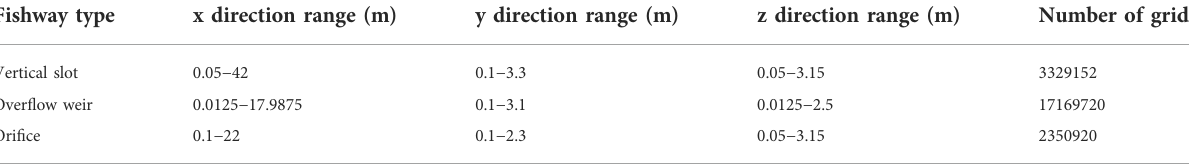
TABLE 1 Details of grid